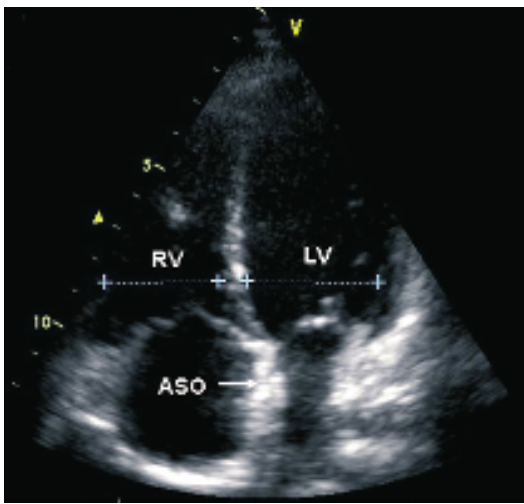
Figure 1 Echocardiography after atrial septal defect closure with an Amplatzer Septal Occluder (ASO): a four-chamber is obtained to measure the maximal right (RV) and left ventric- ular (LV) inlet diame- ter at end diastole. The measurements were made at the tip of the atrio-ven- tricular